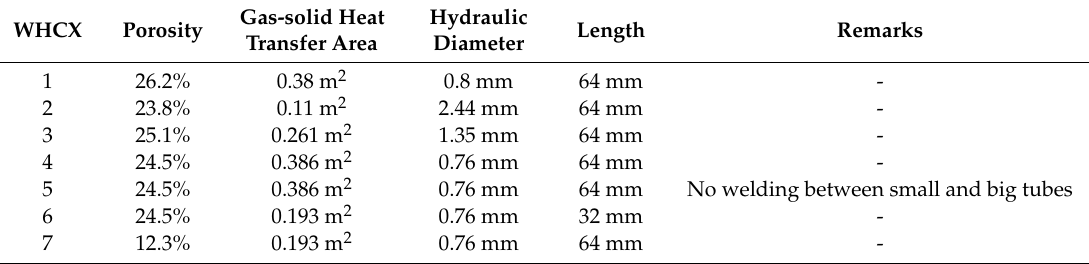
Table 2. Parameters of the WHCXs.